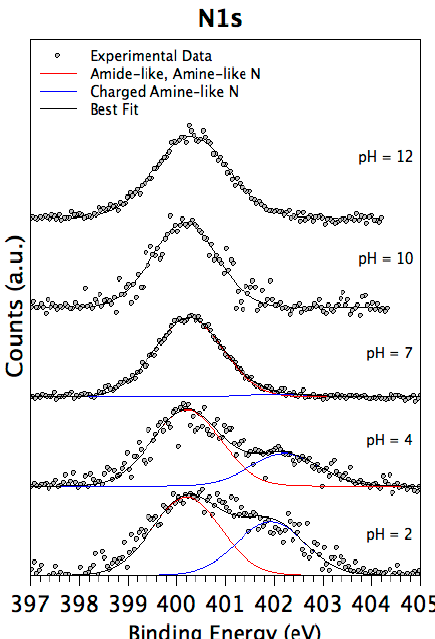
Figure 6. XPS N1s spectra collected on the four monolayer (ML) samples prepared with decreasing pH values.